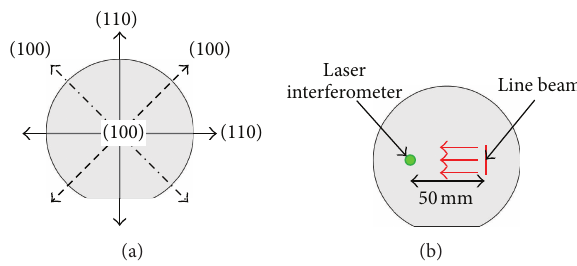
Figure 5: (a) Orientation in a (100) wafer and (b) the setup of the laser source and the laser